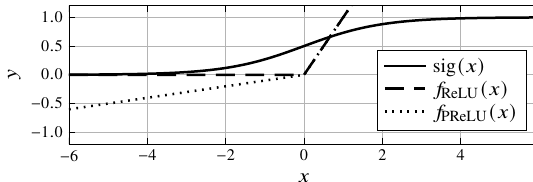
Figure 6. Sigmoid, ReLU and PReLU activation